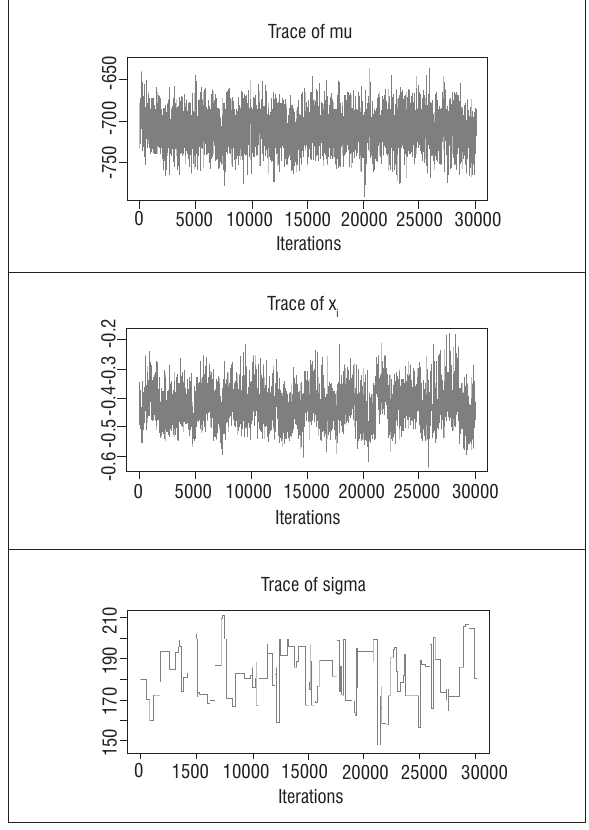
Figure 6: Trace plots of the generalised extreme value distribution parameters using non-informative priors for minimum annual rainfall for Zimbabwe for the period